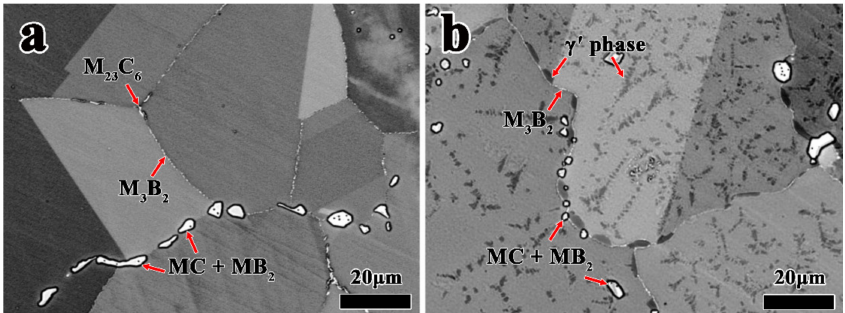
Figure 10. The typical precipitated phase morphology of GH4975 alloy: ( a ) at straight grain bound- aries; ( b ) at serrated grain